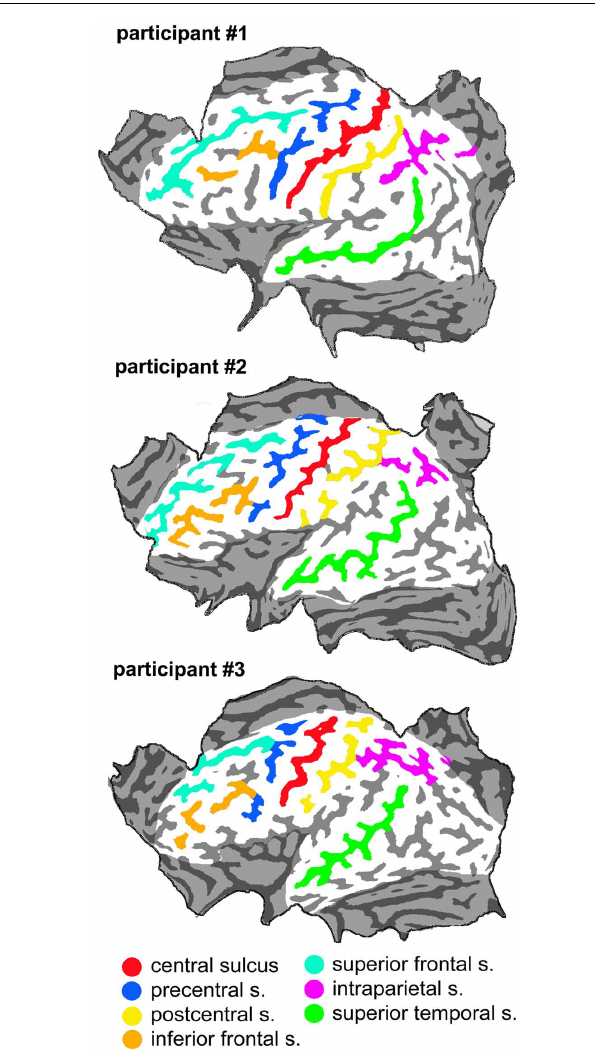
FIGURE 1 | Flat maps of the three participants’ left hemispheres showing the main sulci.